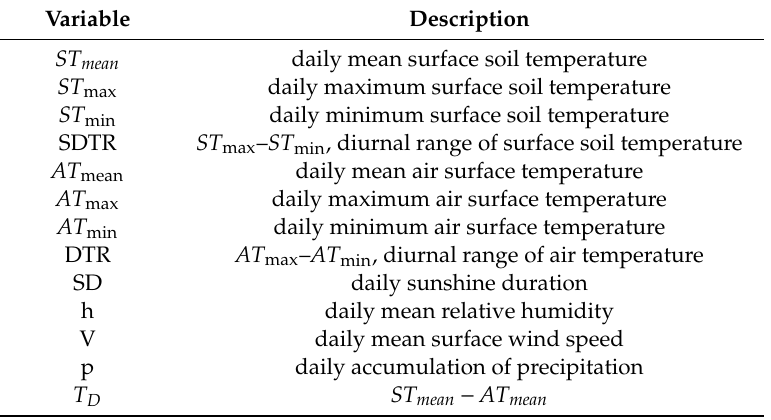
Table 1. Variables used in this paper and their